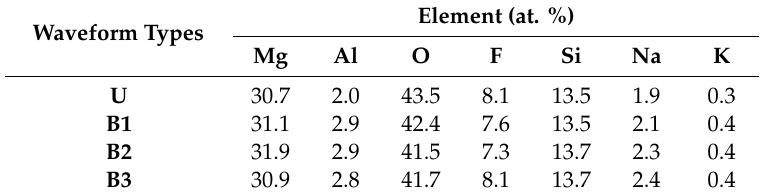
Table 3. Elemental composition of the coatings obtained using EDS analysis.